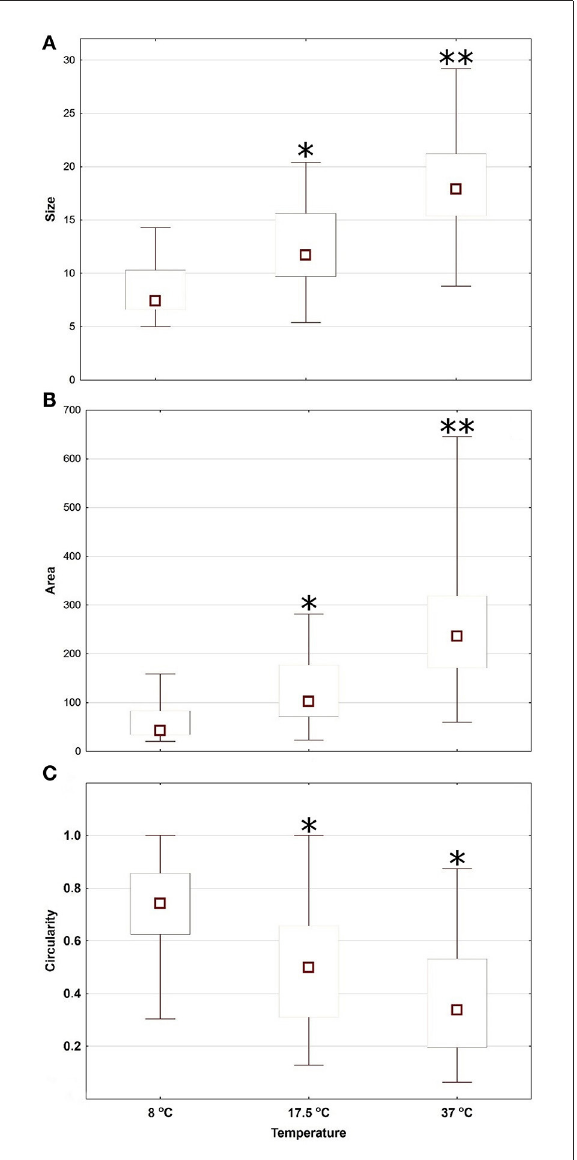
FIGURE3 Morphological parameters (size in µ m determined by fitting an ellipsis equation on the object contour— A , area in µ m 2 determined by counting the pixels inside the object contour— B and circularity index calculated using a standard ellipse formula, where 1 = a perfect circle— C ) of macrophages cultivated at three different temperatures (8, 17.5, and 37 ◦ C) in Experiment 1. Square = median, box = inter-quartile range, whiskers = min-max range. Asterisks represent statistical significance of cell morphological parameters compared between cells cultivated at 8 ◦ C vs. cells cultivated at 17.5 and 37 ◦ C; * p < 0.05, ** p < 0.01; 3 replicates/3 repetitions; univariate ANOVA with Fisher’s LSD post-hoc test.